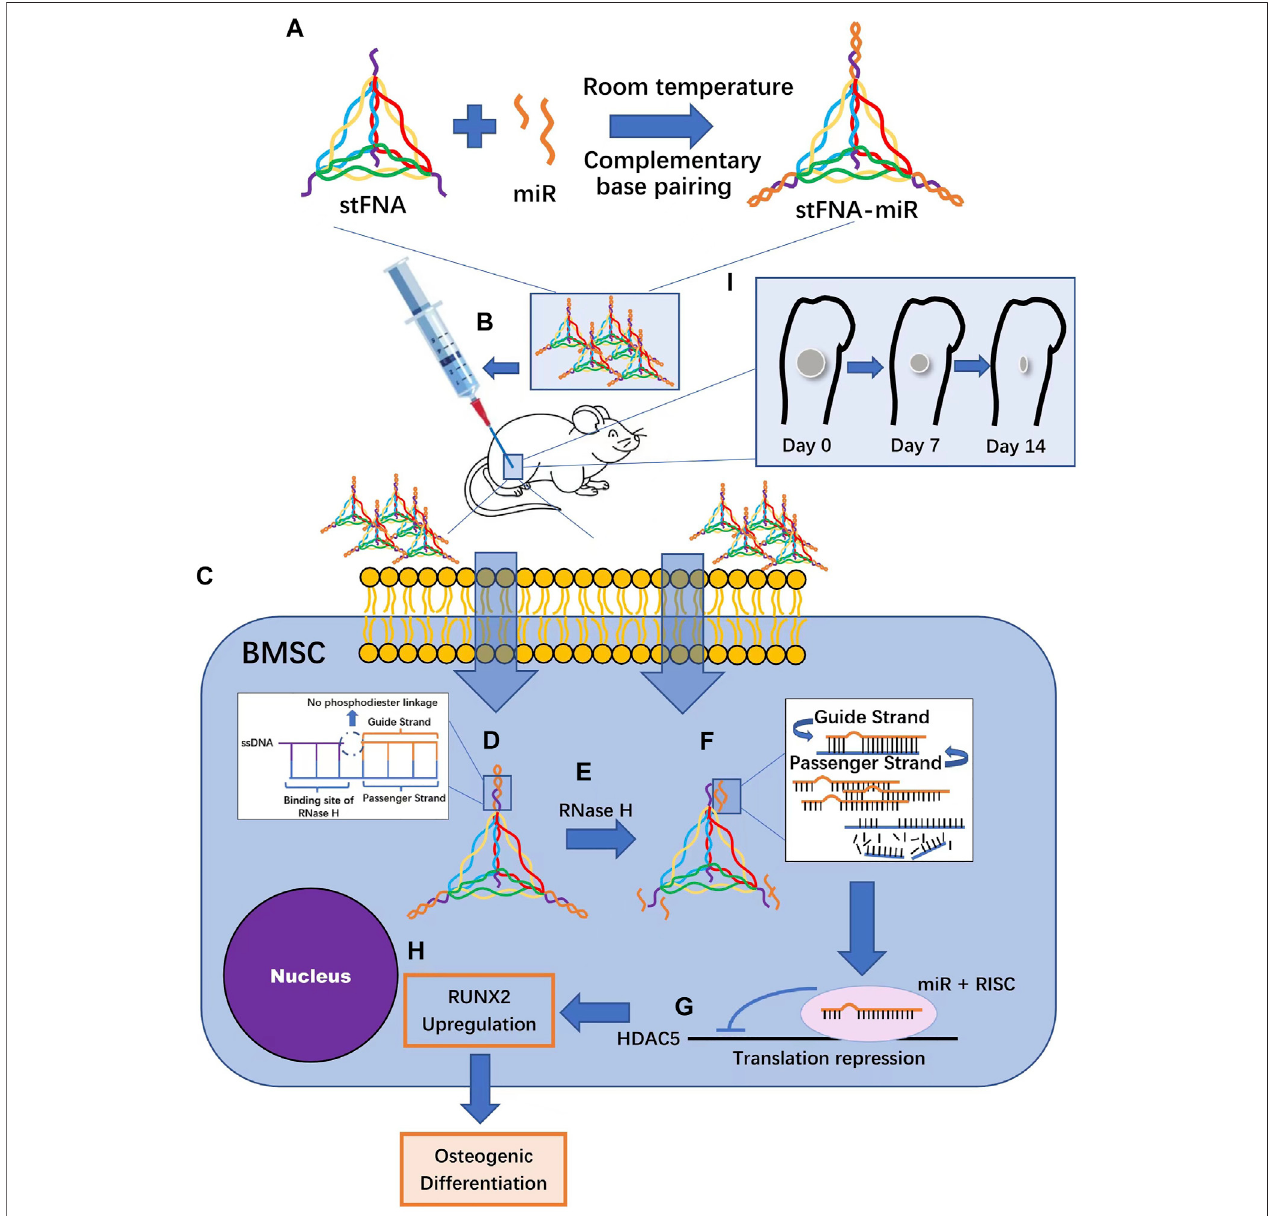
FIGURE 5 | StFNA-miRs promote the healing of mice femoral defects. (A) StFNA-miRs are synthesized at room temperature. (B) The drugs are injected locally around the operation area of 1 mm diameter spherical femoral defect in mice. (C) StFNA-miRs pass through cell membranes along a caveolin-mediated pathway. (D) Double-stranded miR and stFNA form stFNA – miRs through sticky ends complementary pairing. The structures contain the binding site of RNase (H) (E) RNase H degradesthemiRstrandsofheterozygousRNA/DNAmolecules. (F) Thestrands thatislessthermodynamicallystableat the5 ′ endareactively choseastheguide strands and the passenger strands undergo degradation. (G) RNA-induced silencing complex binds to target histone deacetylase 5 (HDAC5)mRNA and the translation is inhibited. (H) The expression of the runt-related transcription factor 2 (Runx2) protein is upregulated and the osteogenic differentiation of bone marrow mesenchymal stem cells (BMSCs) is ultimately promoted. (I) There is obvious bone regeneration in the bone defects of mice.